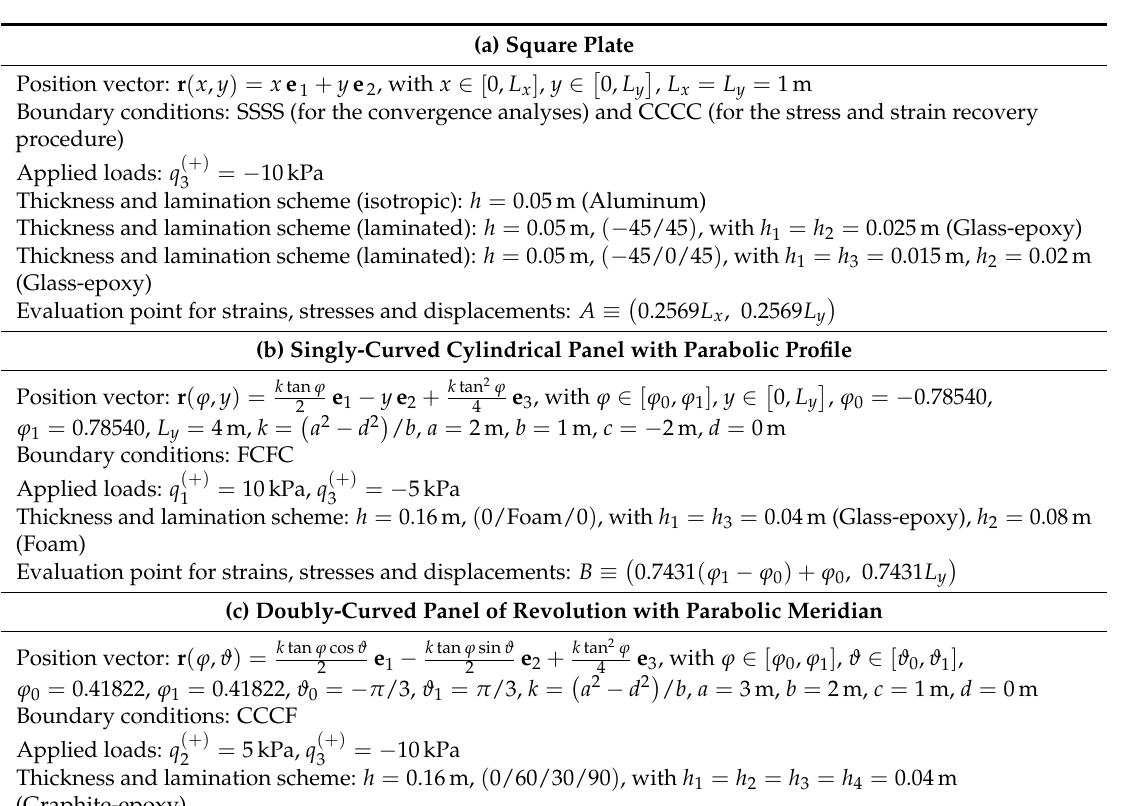
Figure 4. Representation of the geometry of the considered structures: ( a ) Square plate; ( b ) singly-curved cylindrical panel with parabolic profile; ( c ) doubly-curved panel of revolution with parabolic meridian; ( d ) geometric parameters for the parabolic curves. The grid distribution and the number of sampling points required by the GDQ method are also specified. Table 3. Geometric and mechanical properties of the